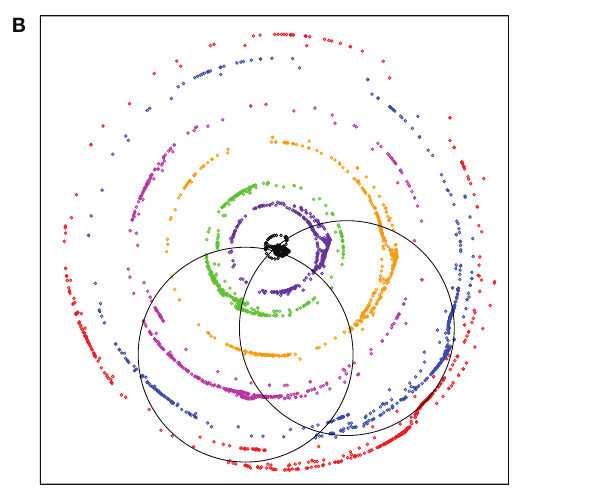
FIGURE 4 | Flocks of size N = 512 and n = 10, moving with the speed of v = 0 . 03 without noise. (A) Single sink state: the fully cohesive and coherent motion of the flock is exhibited by its position at three different instants: 10,000 (blue), 11,000 (green), and 12,000 (magenta). Three straight line trajectories of individual agents are also shown. The frame size is 90 × 90